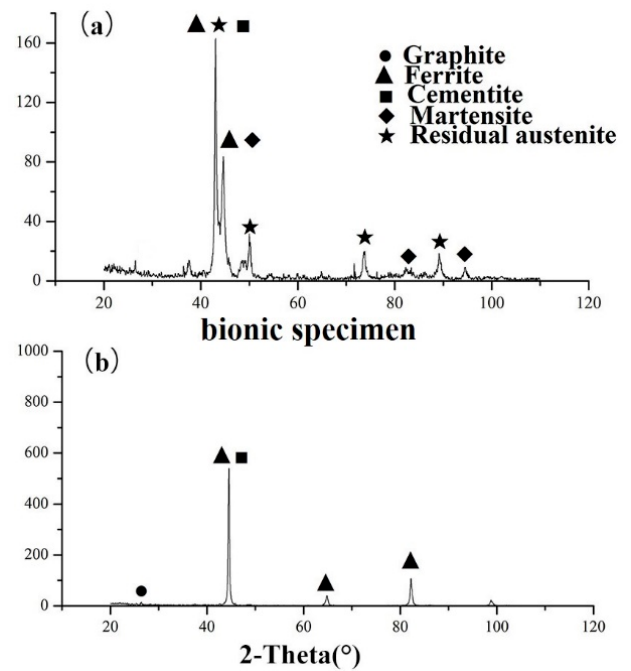
Figure 6. Electron micrograph of the microstructure in the melting and transition zone of a biomimetic unit. ( a ) The melting zone; ( b ) the transition zone.